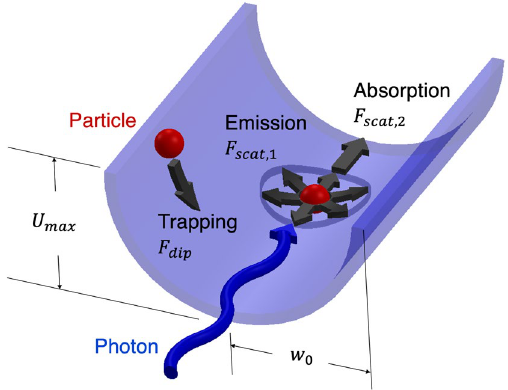
Figure 1. Schematic of the optical forces that the particles experience in the region of large light intensity gradient. U max = α ′ I 0 /( 2 c ε 0 ) is the maximum potential amplitude that is dependent on the maximum light intensity, I 0 , and the beam radius, w 0 . Note the scattering force has two contributions: absorption in the direction of the incoming photon and spontaneous emission resulting in a momentum change in a random direction.